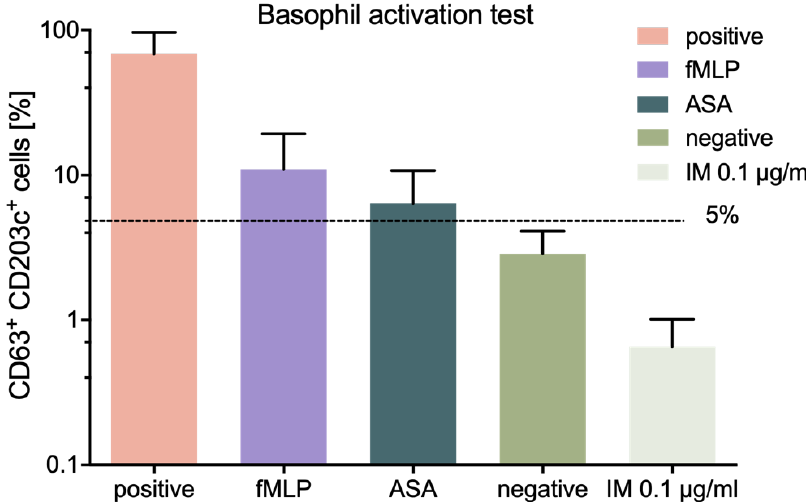
Figure 4. Effect of IM on activation of basophils. The figure shows basophil activation in the presence of: Positive controls, monoclonal antibody FcRI, fMLP, and acetylsalicylic acid (ASA); negative control; and IM peptide (0.1 µg/mL). The graph shows results from 7 independent experiments. Results are presented as mean with SD.